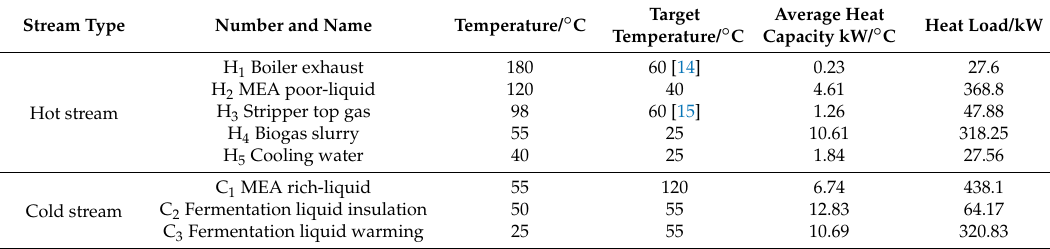
Table 1. Process stream data.